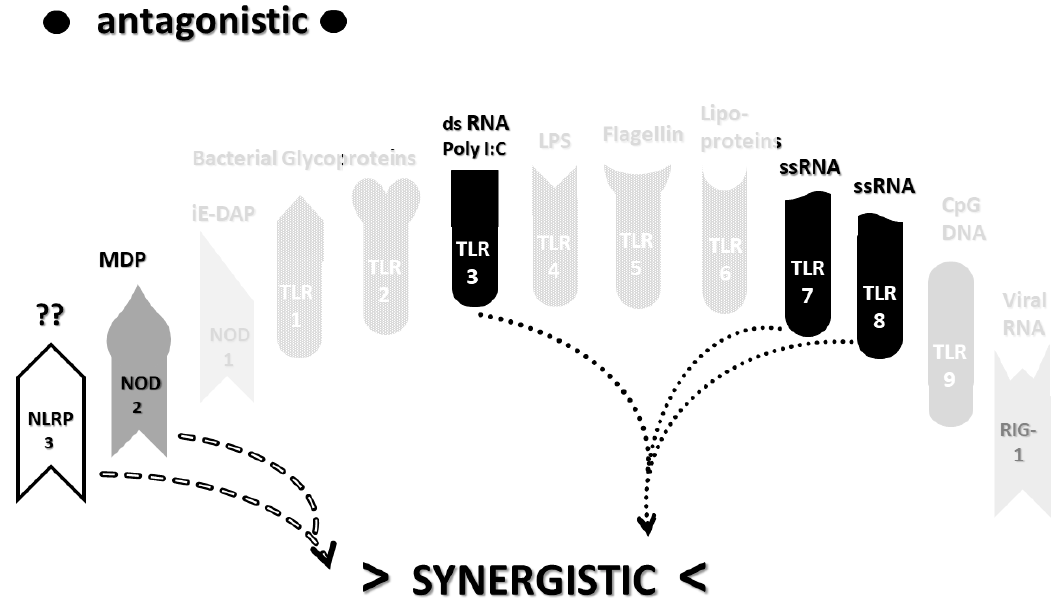
Figure 5. Consensus innate activation profile for coronavirus PAMPs based on the model in Figure 2A,B and data summarized in Table 2. TLR3, TLR7, TLR8, NOD2 and NLRP3 are activated, while the other receptors (faded) are not. The